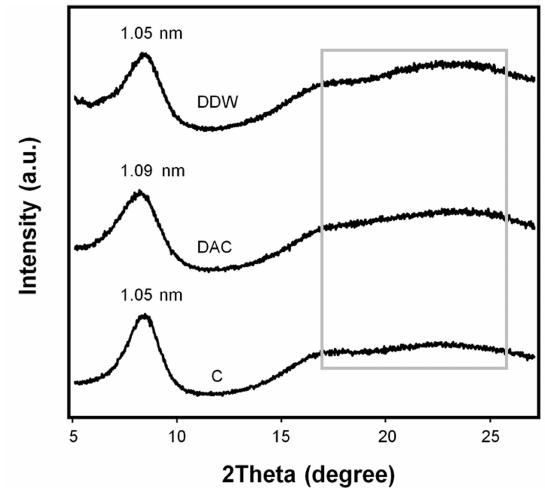
Figure 3. X-ray diffraction patterns of collagens. The sharp peaks represent the distance between the molecular chains of collagen and the broad peaks (in box) represent the amorphous scattering of